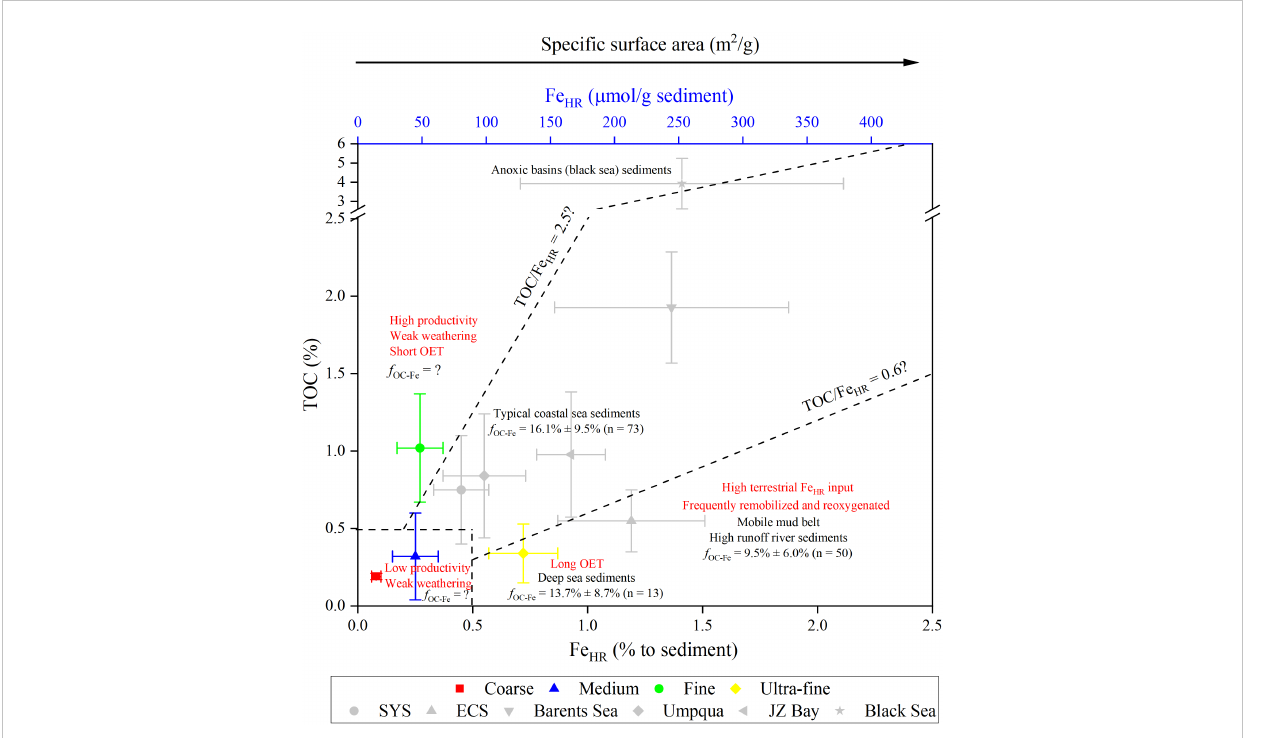
FIGURE 6 Diagram of the relationship between the content of TOC and Fe HR . Speci fi c ranges of TOC/Fe HR ratios characterize different sedimentary environments, and re fl ect the degree of OC-Fe HR complexing in different environments. Data related to OC/Fe HR ratios are derived from this study, Wijsman et al. (2001); Roy et al. (2013); Jessen et al. (2017); Ma et al. (2018); Faust et al. (2021) and Zhu et al. (2012); Zhu et al. (2015). The f OC-Fe data are from Lalonde et al. (2012); Shields et al. (2016); Ma et al. (2018); Faust et al. (2021) and Zhao et al. (2018). OET, oxygen-exposure time; SYS, South Yellow Sea; ECS, East China Sea, JZ Bay, the Jiaozhou Bay. Data are averages of surface sediments (0 – 2 cm) by recalculation of Jessen et al. (2017); Faust et al. (2021) (stations 393, 506 and 448), Shields et al. (2016) and Wijsman et al. (2001) (station